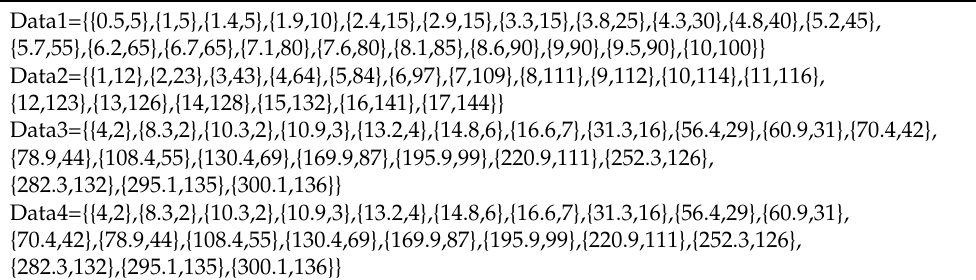
Table 3. The Details of the Datasets {testing time, num. of defects}.